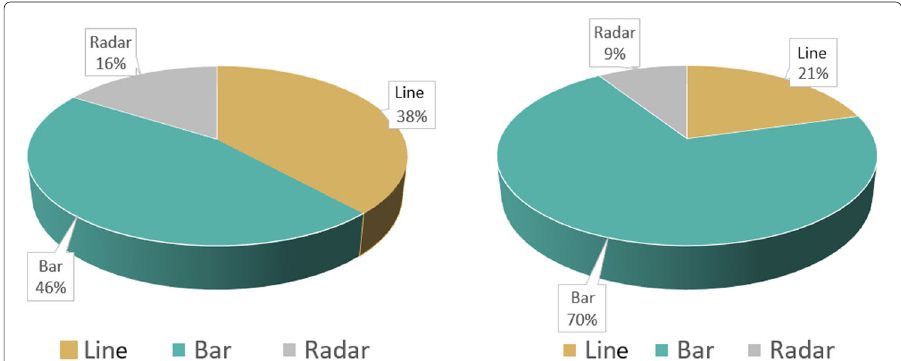
Fig. 8 Preferred forms of visualization. Answers to the question about preferred forms of visualization, considering line, bar and radar graphs (source: (Ferreira et al. 2019))